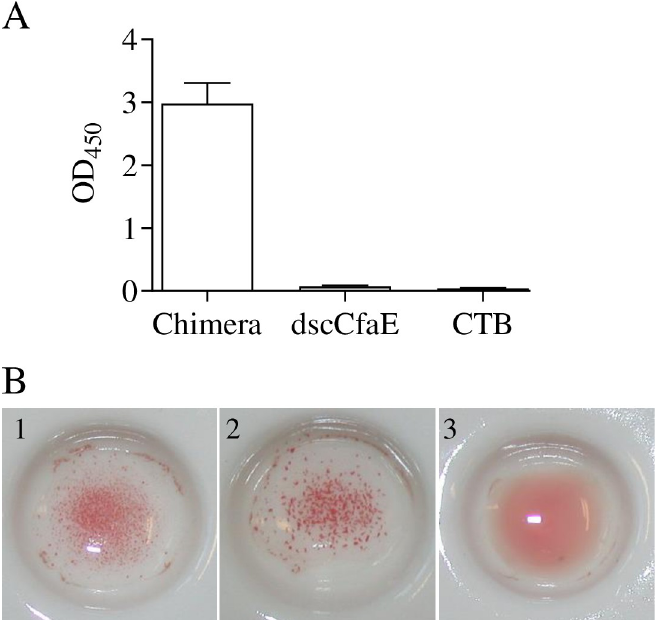
Fig 3. Binding functionalities of the dscCfaE-CTA2/CTB chimera. (A) Binding of chimera protein to solid-phase GM1 by ELISA. GM1-coated plates were incubated with chimera, dscCfaE, or CTB. Rabbit anti-dscCfaE and goat anti- rabbit IgG-HRP antibodies were used as the primary and secondary antibody, respectively. The bars represent mean absorbance at OD 450nm (+SEM of 4 replicate wells from one representative experiment). (B) In vitro adherence of chimera to bovine erythrocytes, measured by visual hemagglutination. Polystyrene beads were coated with chimera (1), dscCfaE (2) or CTB (3) and incubated with bovine erythrocytes.